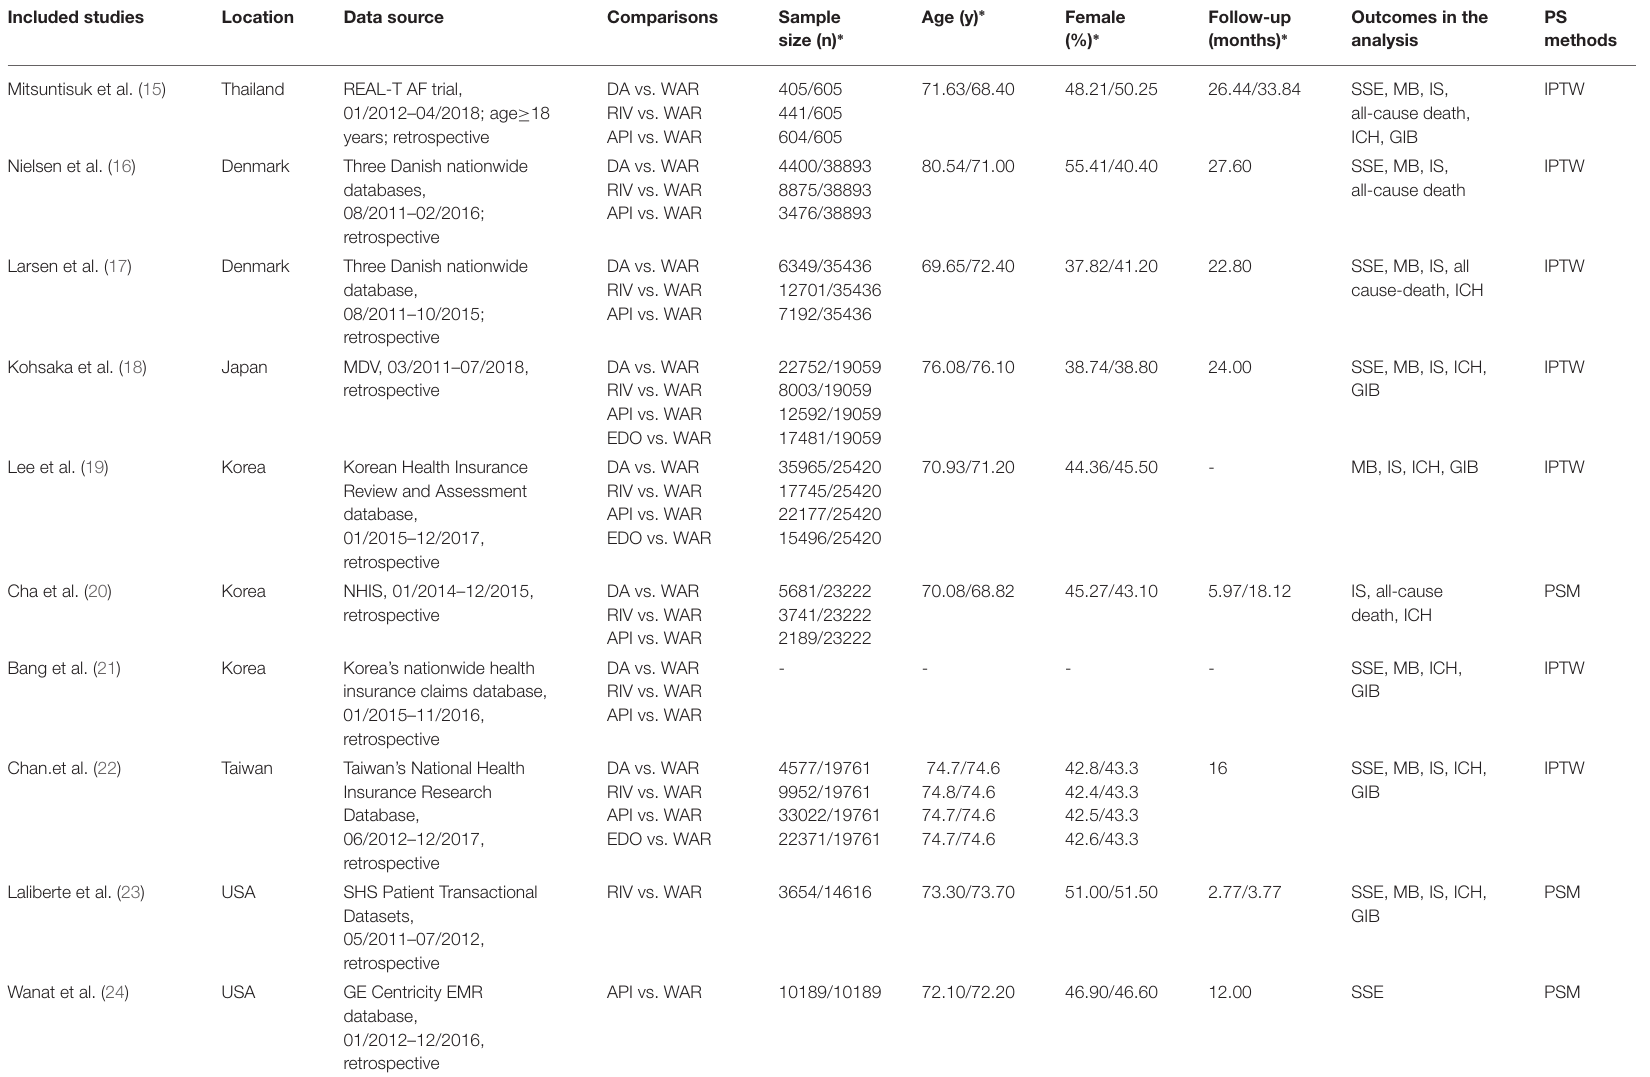
TABLE 1 | Baseline characteristics of included observational